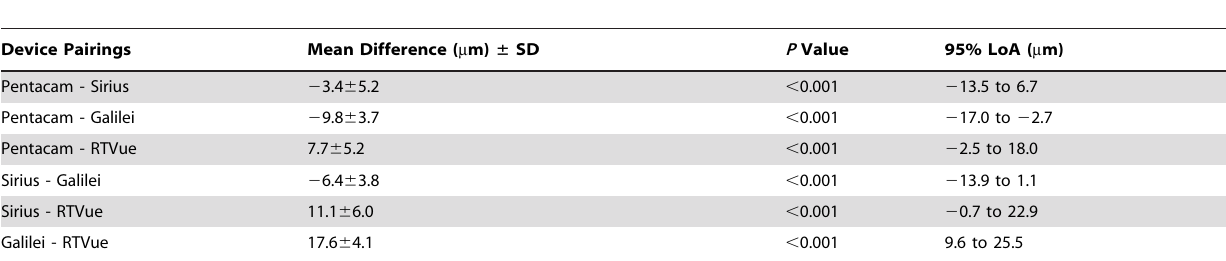
Table 3. Mean difference of thinnest corneal thickness, corresponding results of Bonferroni post hoc comparison and 95% limits of agreement (LoA) among the 4 investigated devices.